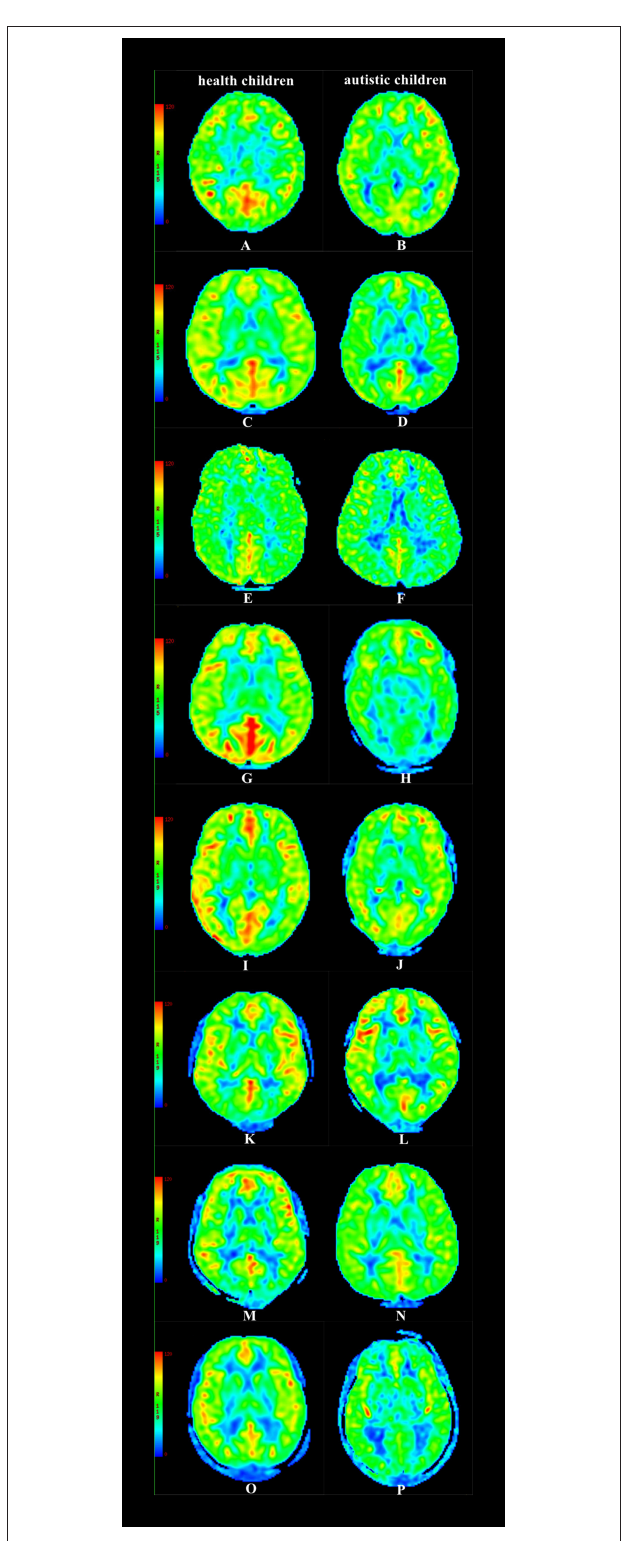
FIGURE 4 | CBF maps (A) Male, 2.3 y, healthy children. (B) Female, 2.4 y, autistic children. (C) Male, 3.3 y, healthy children. (D) Male, 3.6 y, autistic children. (E) Female, 4.5 y, healthy children. (F) Male, 4.4 y, autistic children.